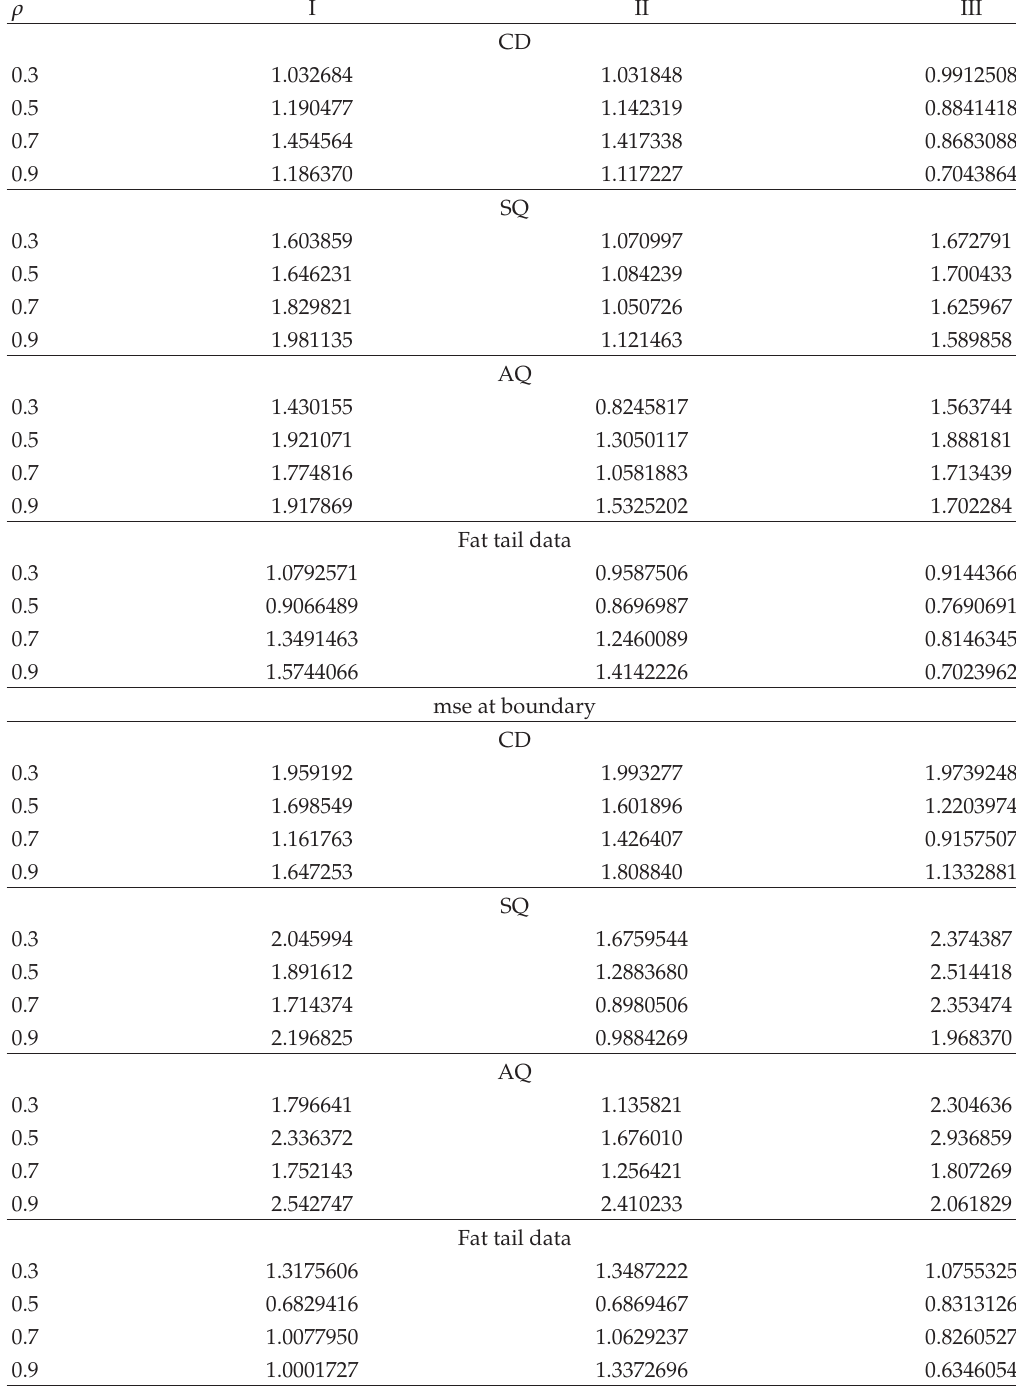
Table 3: Simulation results of global and local mean squared using AR (cid:5) 1 (cid:6) with di ff erent parameters. The first half of the table displays the global mean squared